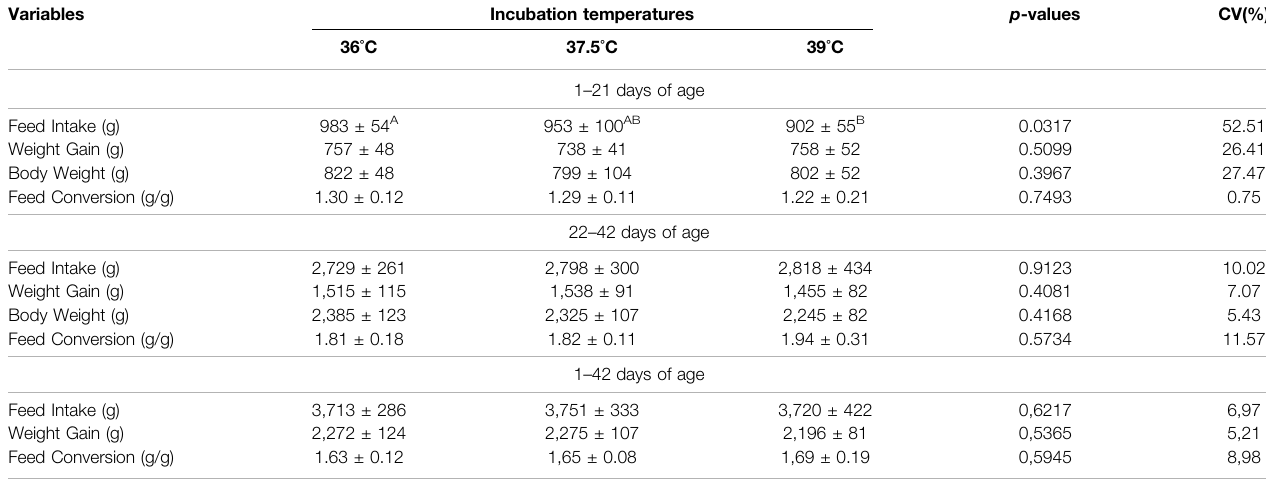
TABLE 6 | Broiler body weight at 21 and 42 days of age and performance from day 1 to 21 and from day 22 to 42 of age, according to incubation temperature.